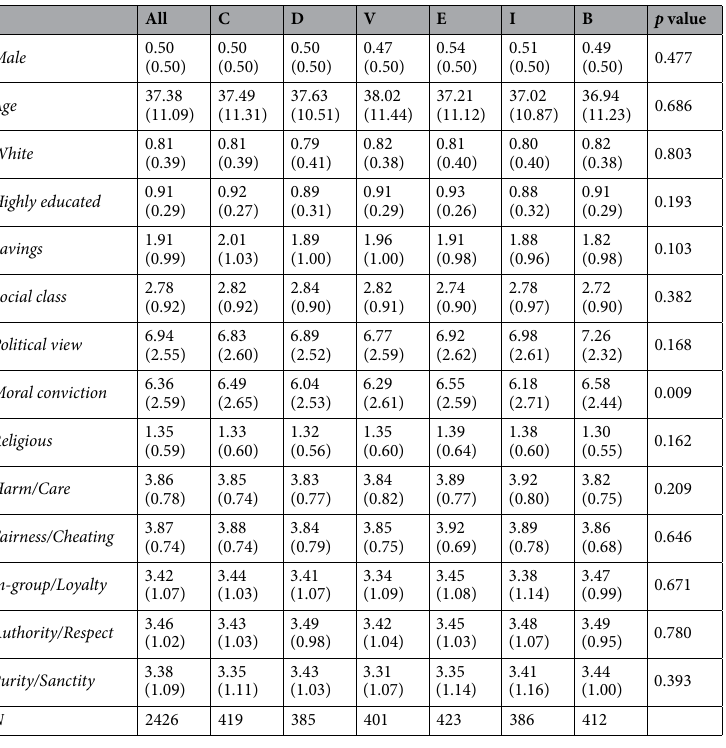
Table 1. Summary statistics by message. Means reported, standard deviations in parentheses. Column abbreviated names refer to Consequentialism (C), Deontology (D), Virtue ethics (V), Ethical egoism (E), Imperative (I) and Baseline (B). The p-values correspond to Kruskal-Wallis equality-of-populations rank test 2 for continuous variables, and χ tests for binary variable (i.e. Male, White, and Highly educated).